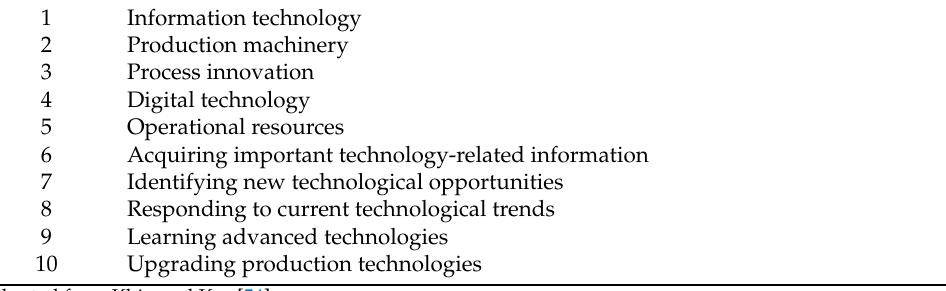
Table 3. Measurement items for financial capability and technological